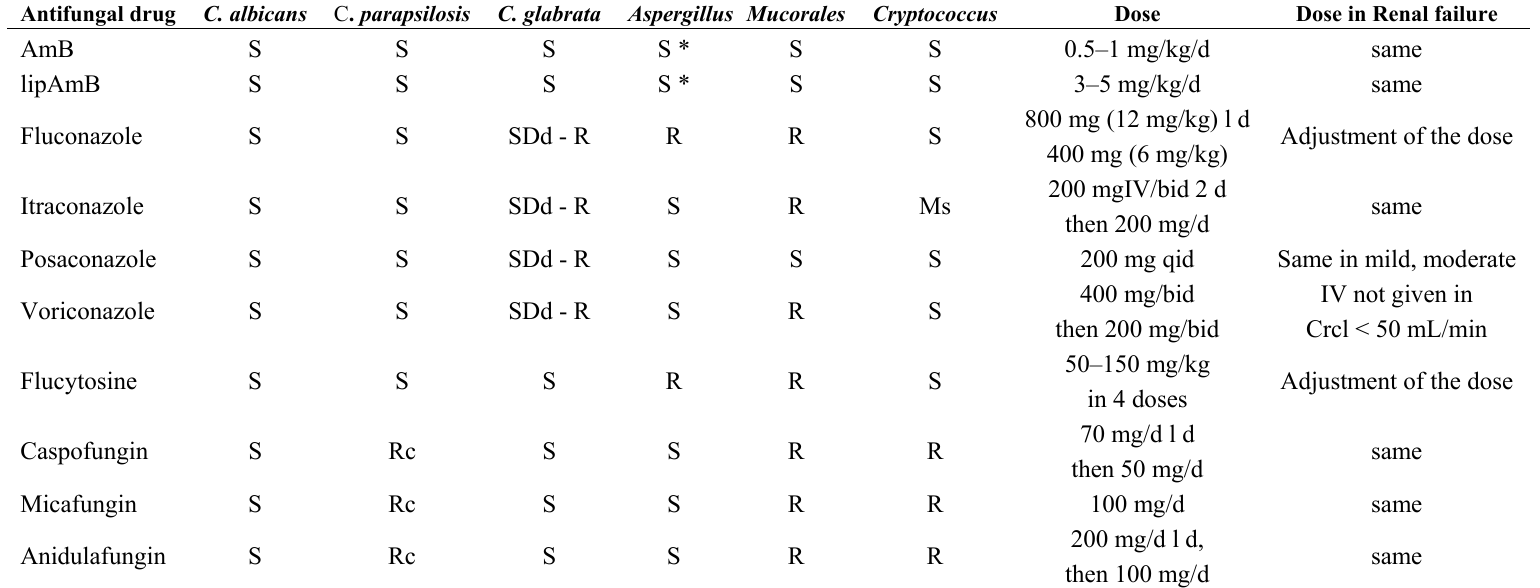
Table 6. Spectrum of antifungal drugs, usual dose in invasive infections and dose adjustement in renal